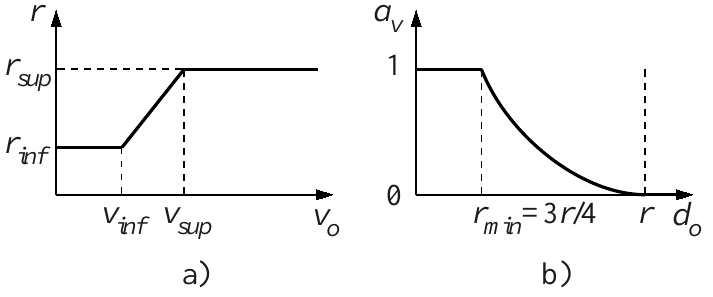
Figure 4. ( a ) Radius of the region of influence as a function of the obstacle velocity; ( b ) activation parameter a v as a function of the distance from the obstacle d o